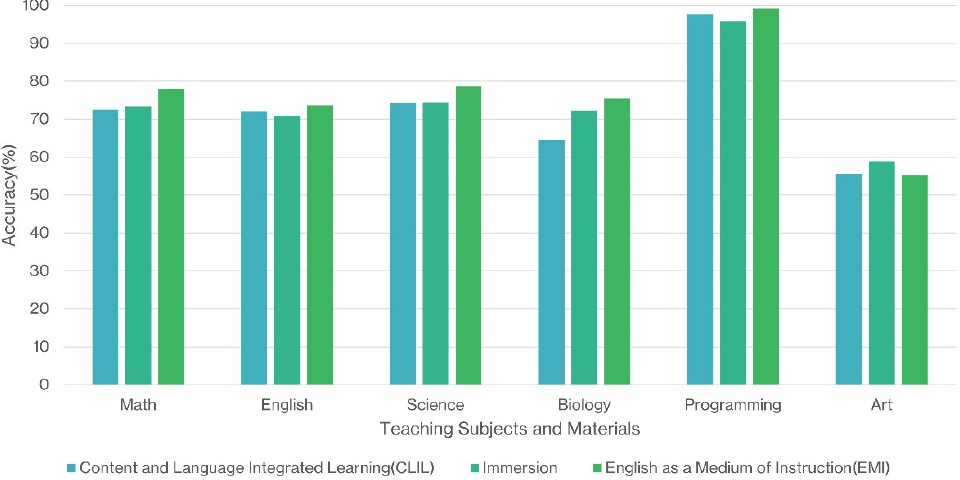
Figure 11. The total accuracy of our method for different teaching subjects and